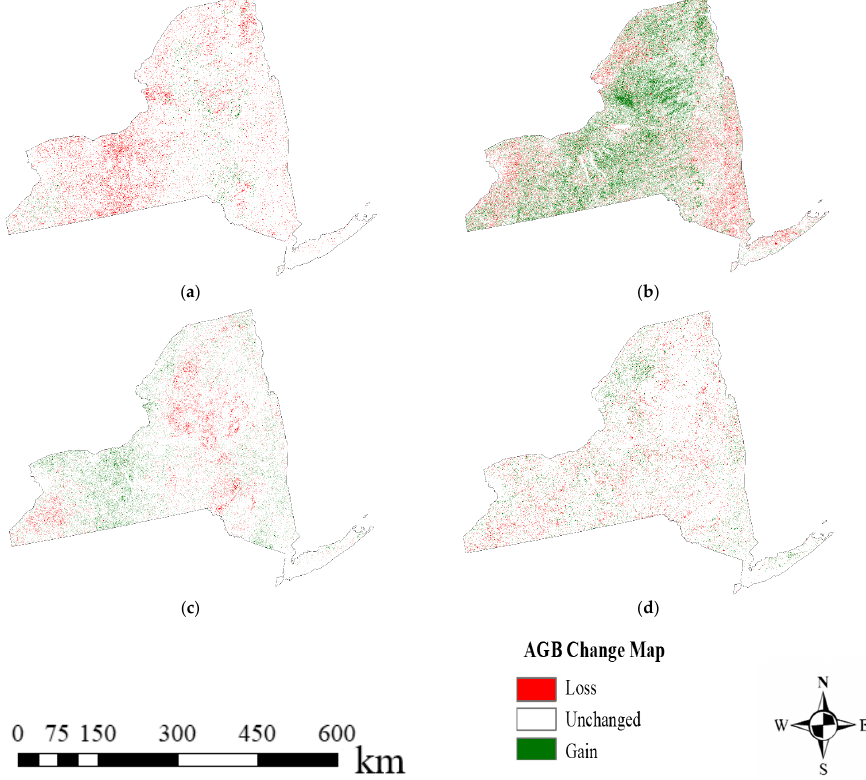
Figure 5. The 5-year increment change maps to analyze loss (red), gain (green), and unchanged (blue) areas in NYS for time spans: ( a ): 2001–2006, ( b ): 2006–2011, ( c ): 2011–2016, and ( d ): 2016–2019. Schleeweis et al. (2020) [45] utilized the Landsat archive and an ensemble of disturb- ance algorithms to produce the US national maps attributing forest change from 1986 to 2010. The disturbance map includes the following classes: stable (i.e., no change), remov- als, fire, stress, wind, conversion, and other. The most dominant class of forest change in NYS is removal. For all training datasets, land cover and land use observations were col- lected. Plots labeled as mechanical forest change were labeled as removal or conversion depending on the evidence of vegetation recovery and/or land use change. The removal class has 82.3% user’s and 72.2% producer’s accuracy, respectively. Figure 6 shows the removal disturbance maps of a region in north part of NYS from 2000 to 2010. The AGB map of each year clearly shows the removal occurrence according to that year, which in- dicates the reliability of our RF historical AGB modeling.